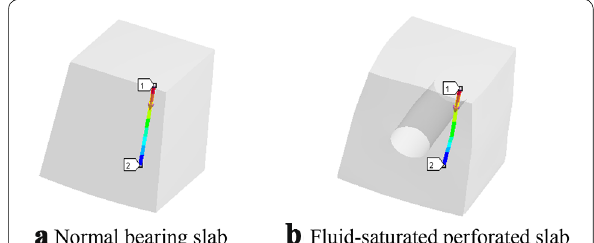
Figure 8 Path diagrams of unit body. a Normal bearing slab. b Fluid-saturated perforated slab